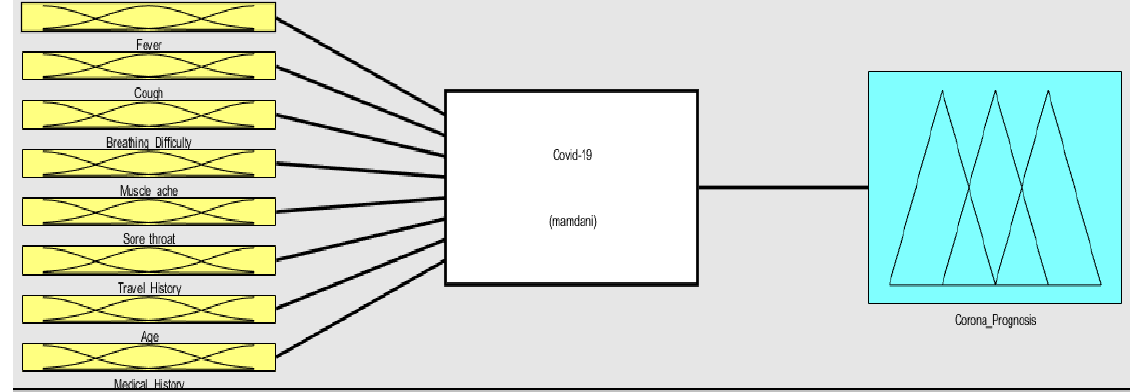
Fig. 3. Basic structure of FIS system.